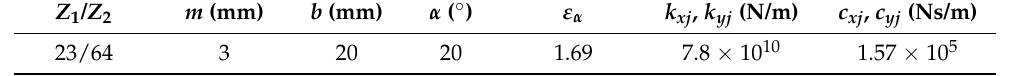
Table 1. Basic parameters of spur gear pair. Z 1 / Z 2